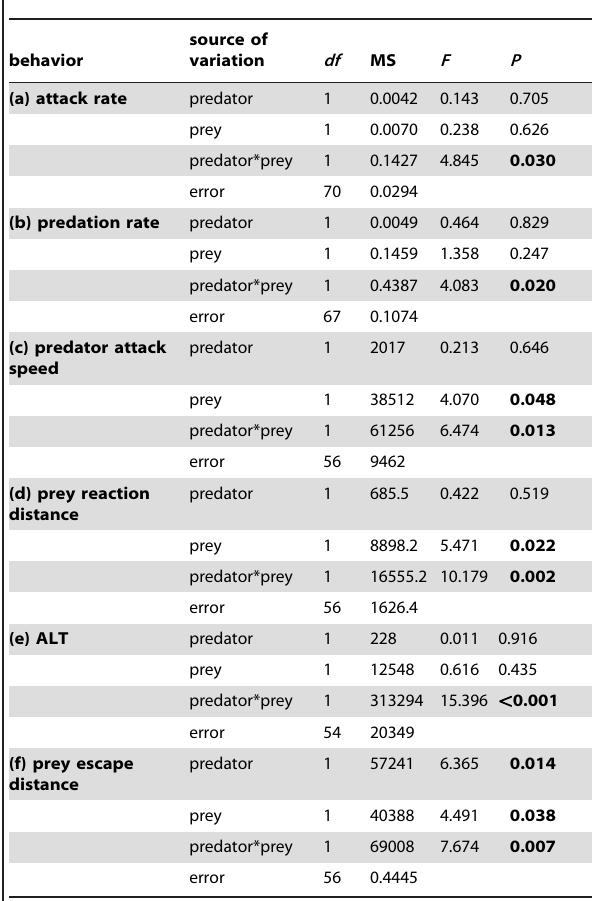
Table 2. Comparison of the effects of elevated CO 2 (440, 880 m atm) on interactions between a predator ( Pseudochromis fuscus ) and prey ( Pomacentrus amboinensis ) on 6 performance variables: (a) attack rate (b) predation rate (c) predator attack distance (d) prey reaction distance (e) ALT and (f) prey escape distance.